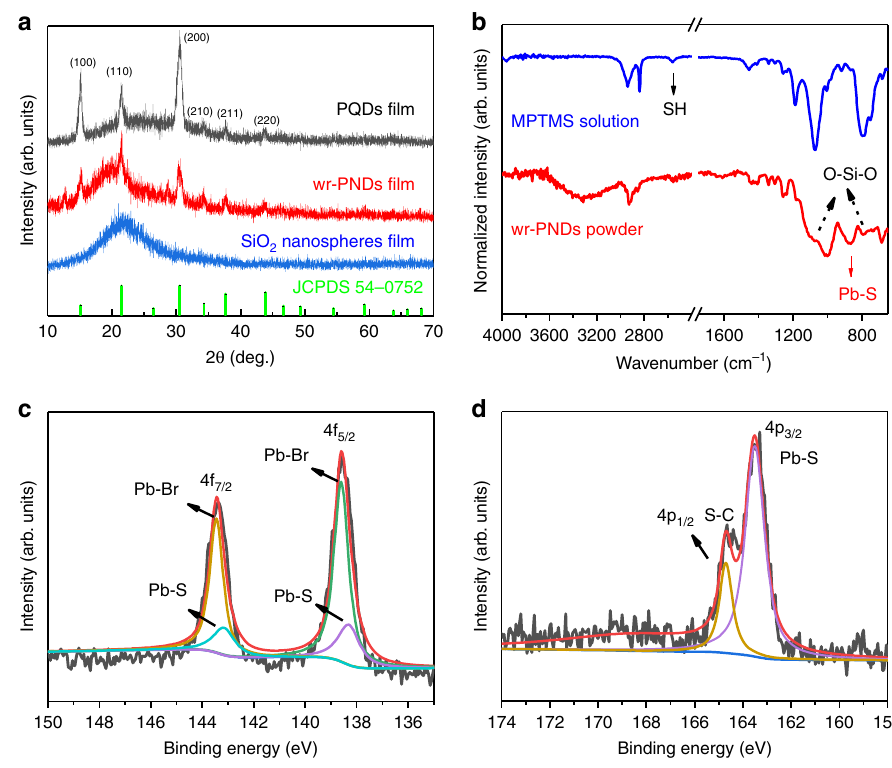
Fig. 2 Spectroscopic veri fi cation of the Pb-S bonding between the PQDs and silica shell. a Powder XRD spectra of wr-PNDs, PQDs, and SiO 2 nanospheres. b FTIR spectra of wr-PNDs powder (red), MPTMS solution (blue). c , d XPS of Pb (4f) and S (4p) regions in wr-PNDs. Source data are provided as a Source Data fi le.